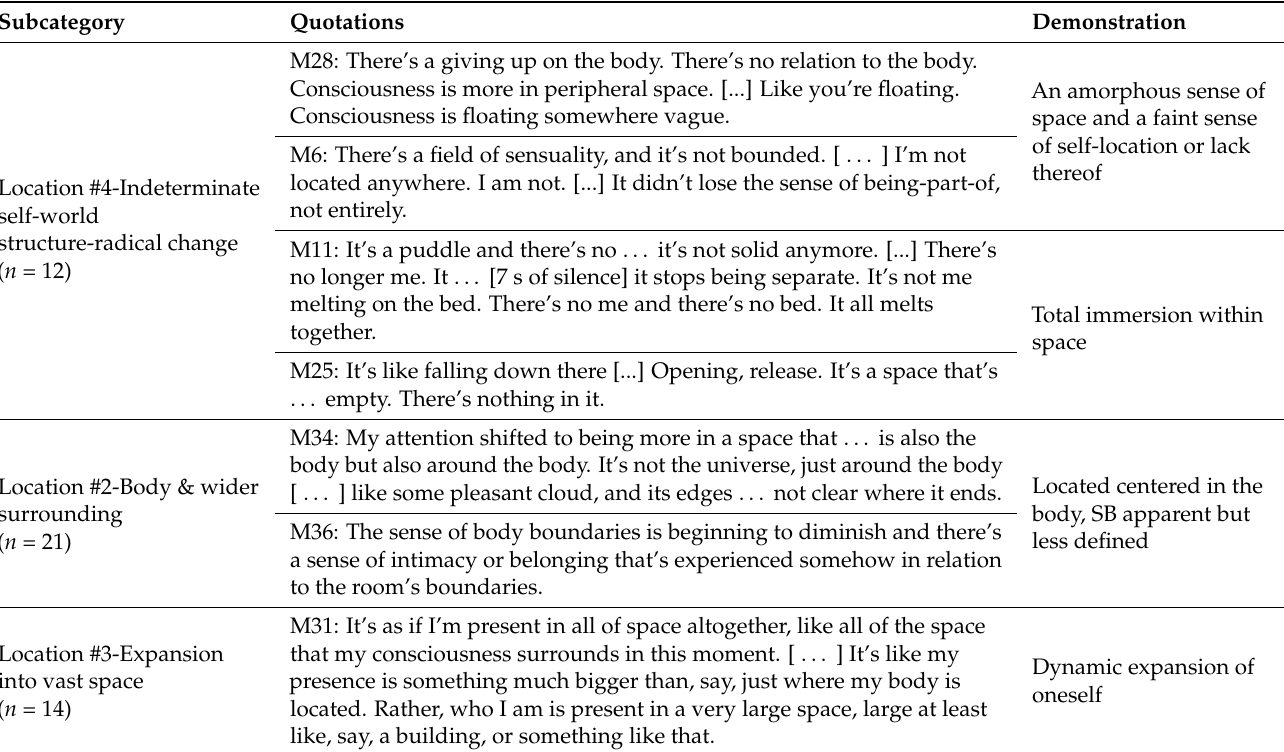
Table 6. SB − representative examples of